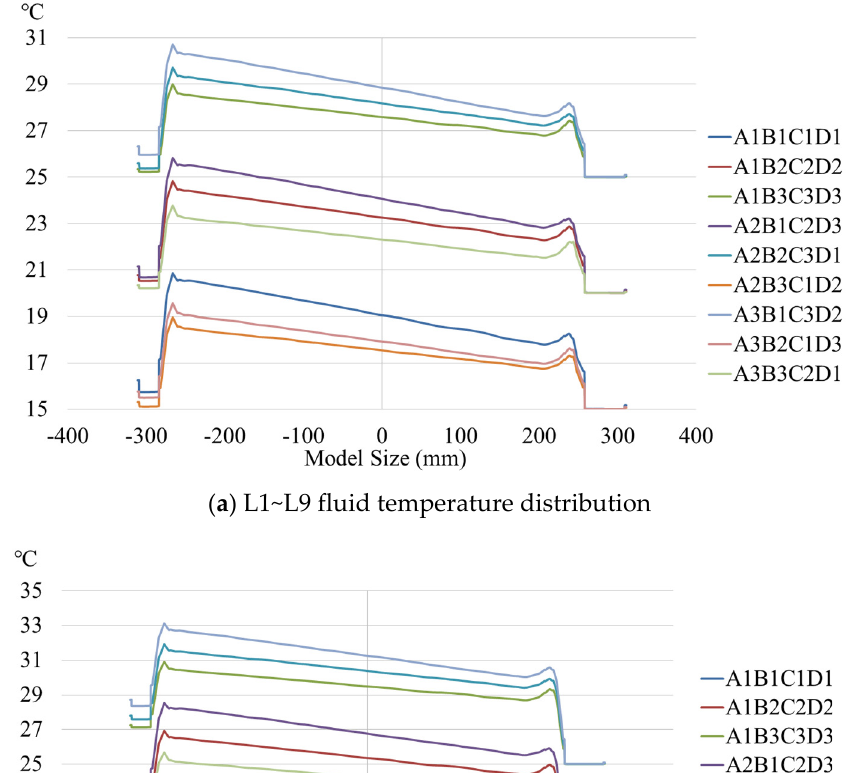
4 Table 4. Comparison of the heat dissipation performance of different design parameters (orthogonal arrays). Exp.